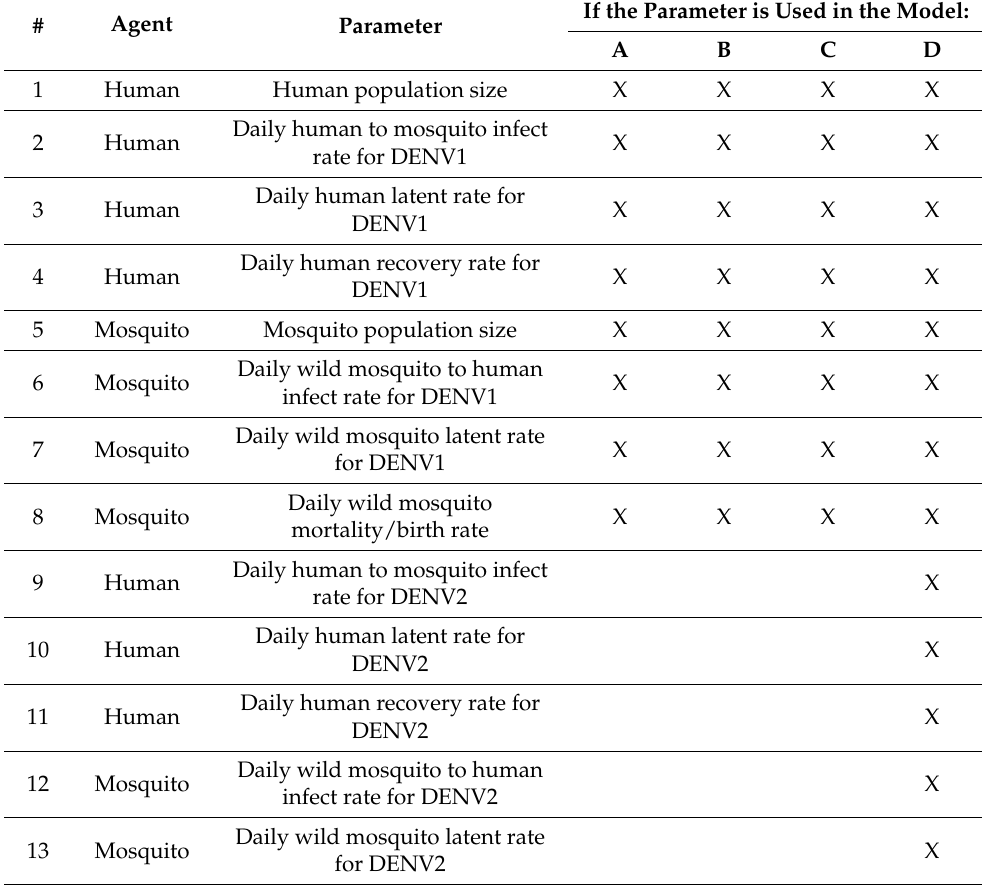
Table 3. Parameters used in each of the four